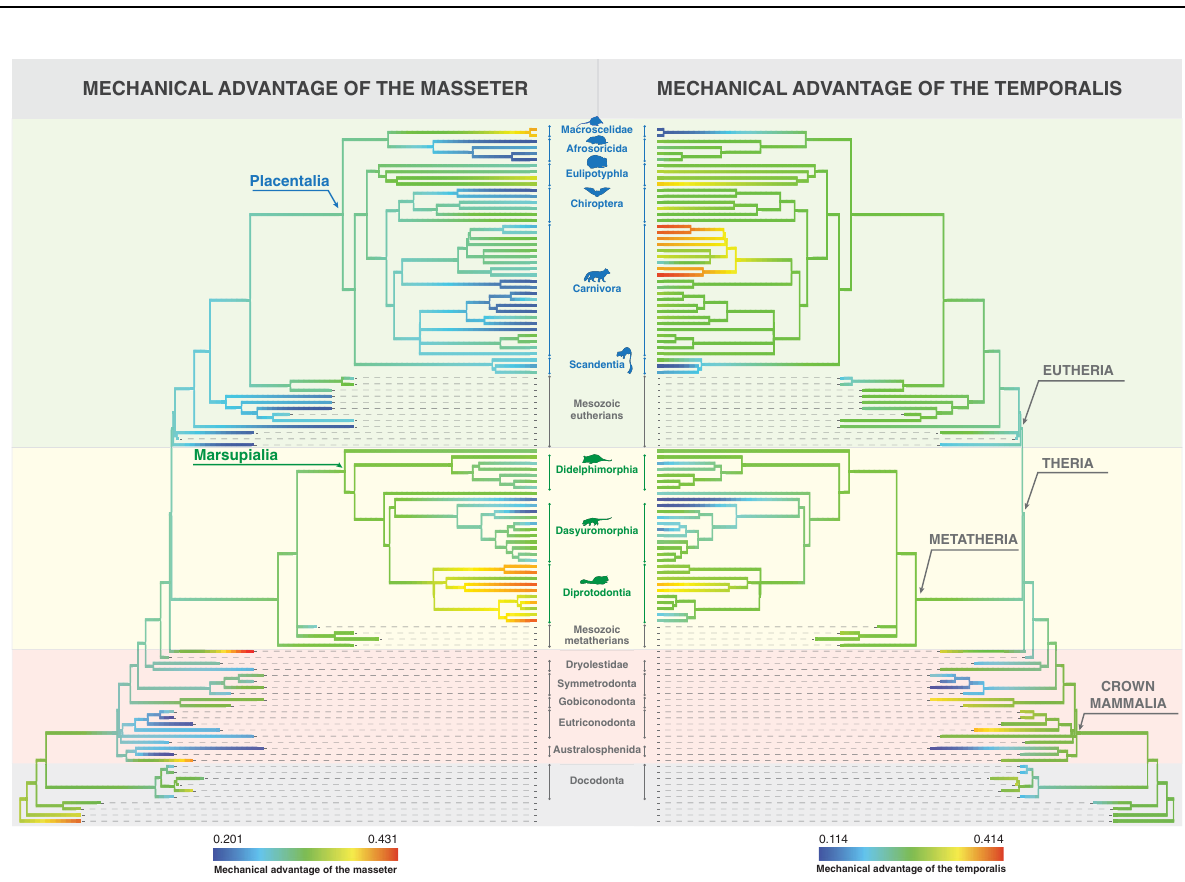
Fig. 5 Mechanical advantage values of the masseter and temporalis when biting at the jaw tip visualized in the context of the phylogeny used in this study. See Supplementary Fig. 7 for individual taxon